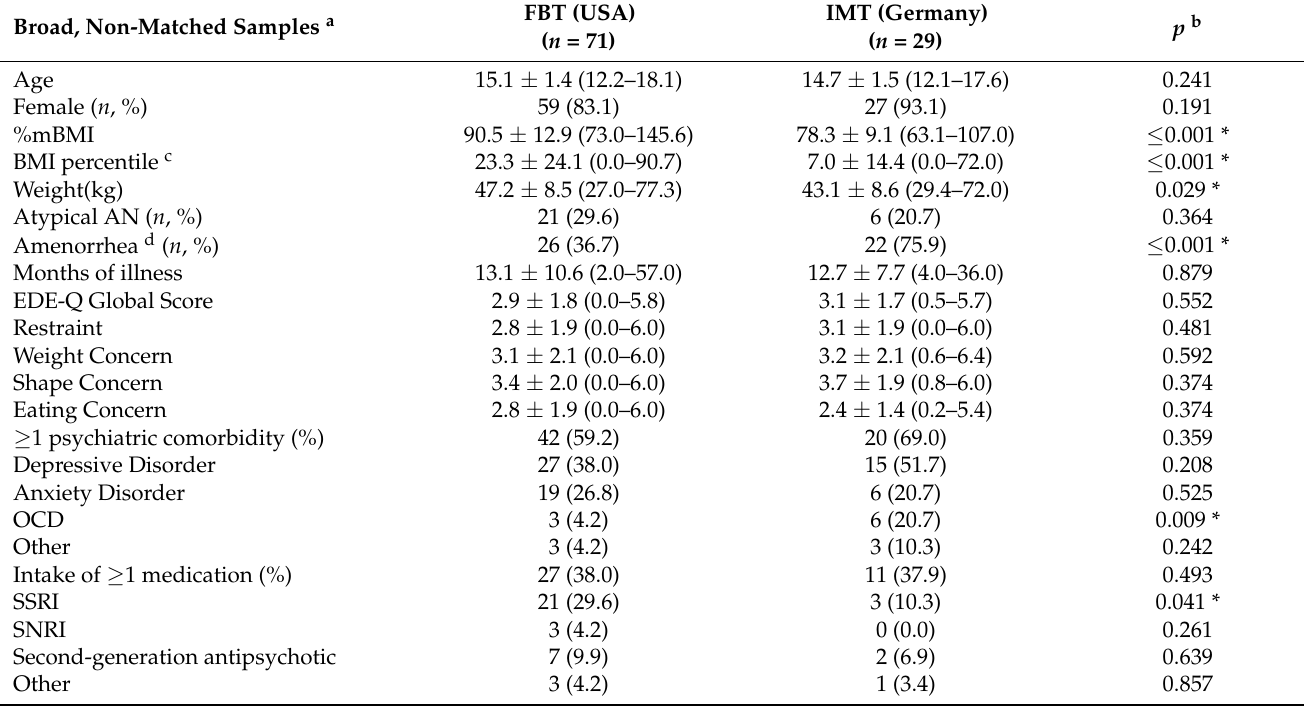
Table 3. Group differences in baseline key clinical characteristics in the FBT and IMT